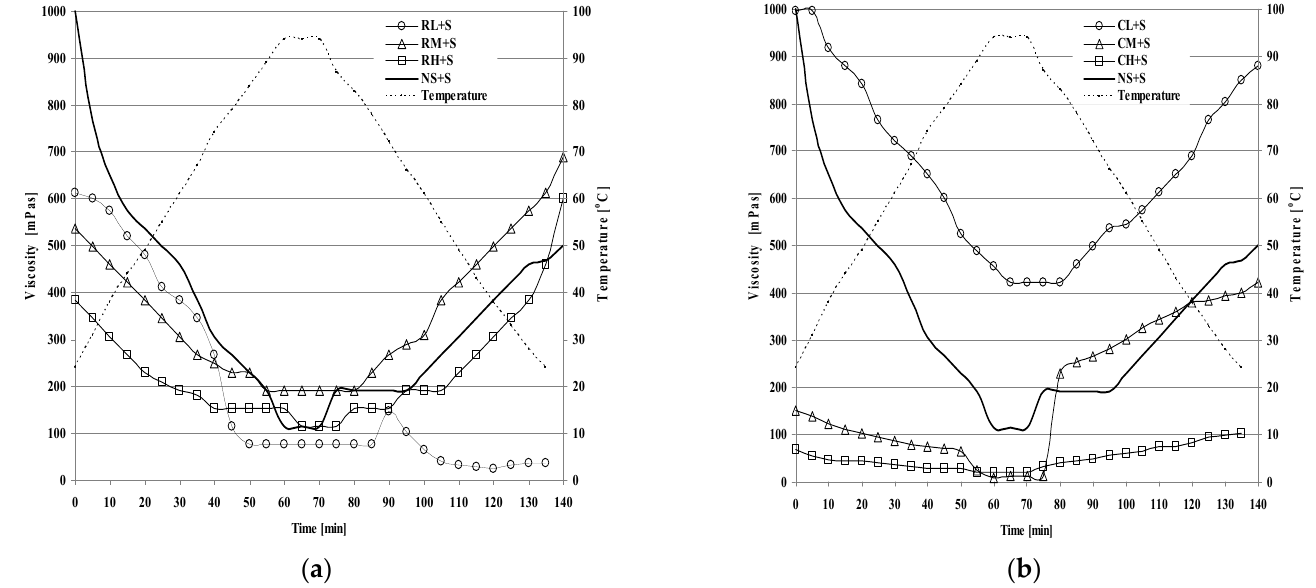
Figure 1. Viscosity curves of blackberry jelly-like desserts obtained from chemically modified corn starch sweetened with sucrose ( a ) or xylitol ( b ).